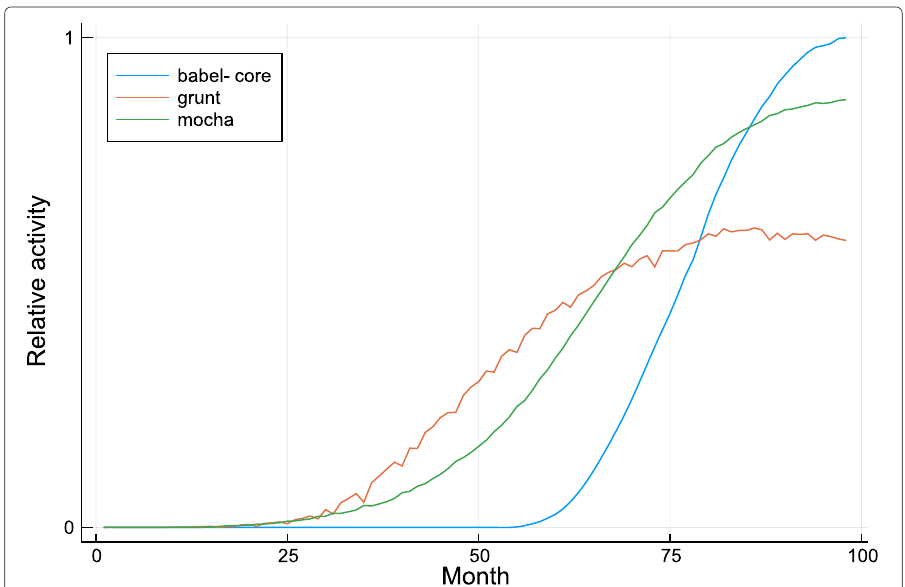
Fig. 15 Cargo community activity. Relative activity of each community in each month. The communities are named by important packages as detailed in the “Methods” section